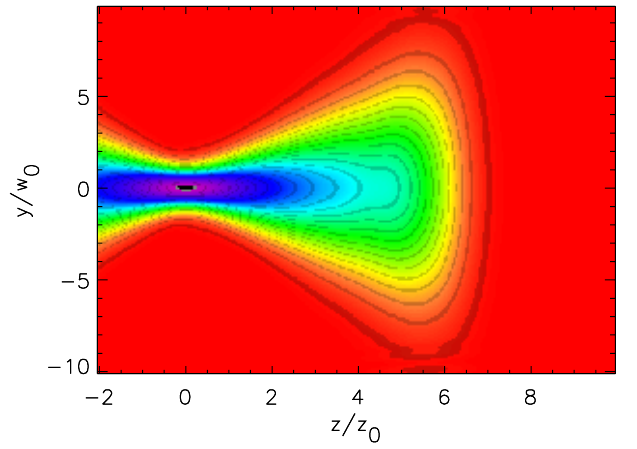
FIG. 2. (Color) Amplitude contour plot of a laser pulse launched into a vacuum domain, propagating through the focus.